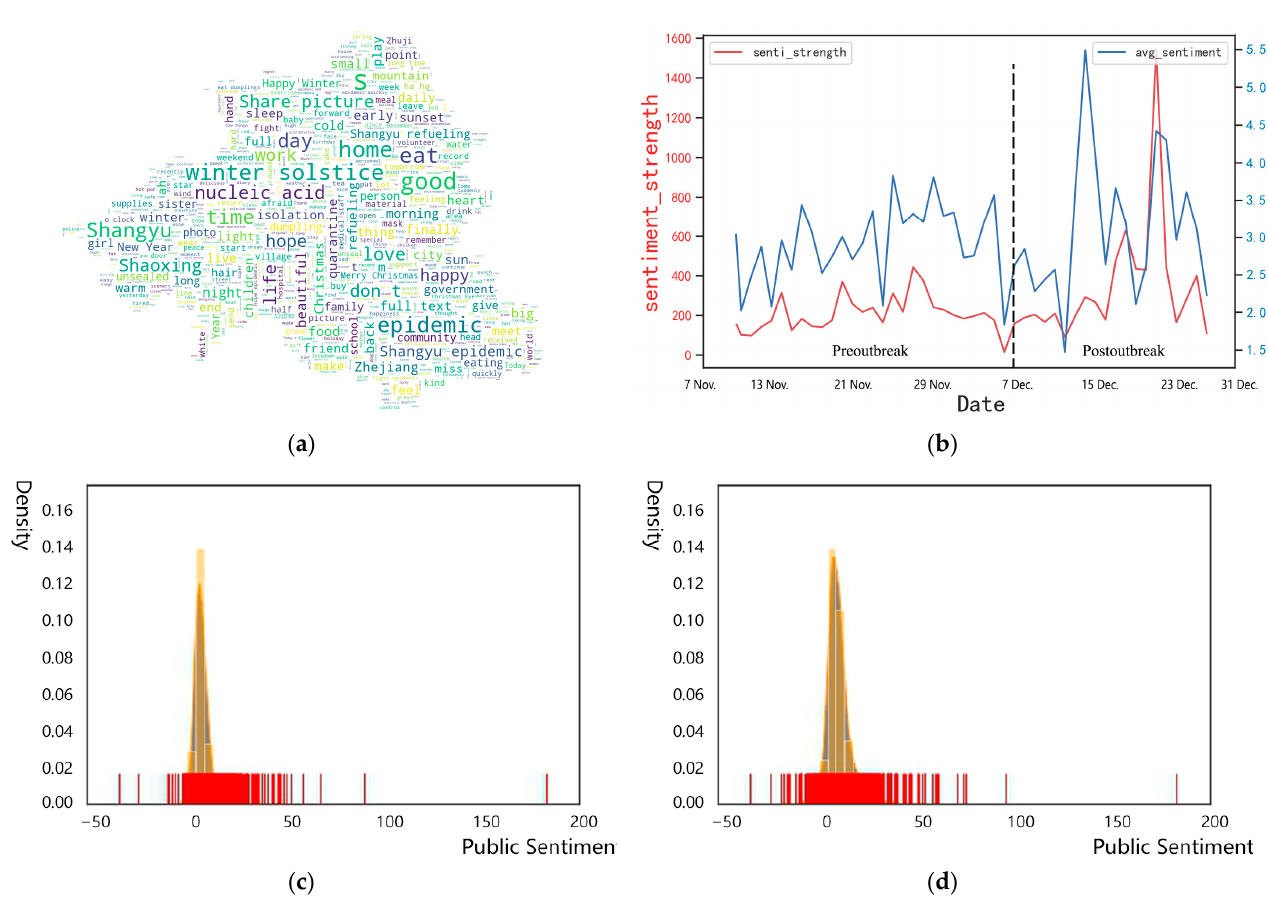
Figure 6. Analysis of the word cloud and kernel-density distribution of microblogs before and during the pandemic: ( a ) Word cloud map of pandemic-related microblogs in Shaoxing. ( b ) Line chart of daily public sentiment strength before and after the pandemic. ( c ) Histogram of kernel-density distribution of prepandemic public sentiment. ( d ) Histogram of kernel-density distribution of public sentiment after the pandemic outbreak.